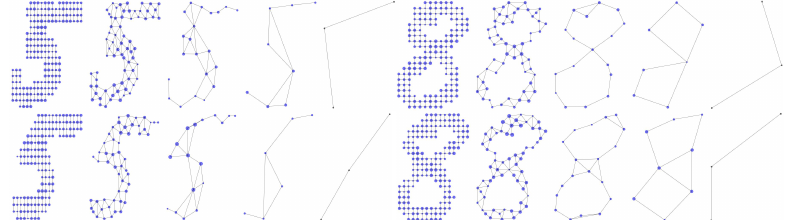
Figure 3. Coarsening of four graphs built from MNIST digits using Loukas’s algorithm. The bigger the node, the wider the neighborhood pooled. Similar digits share similar